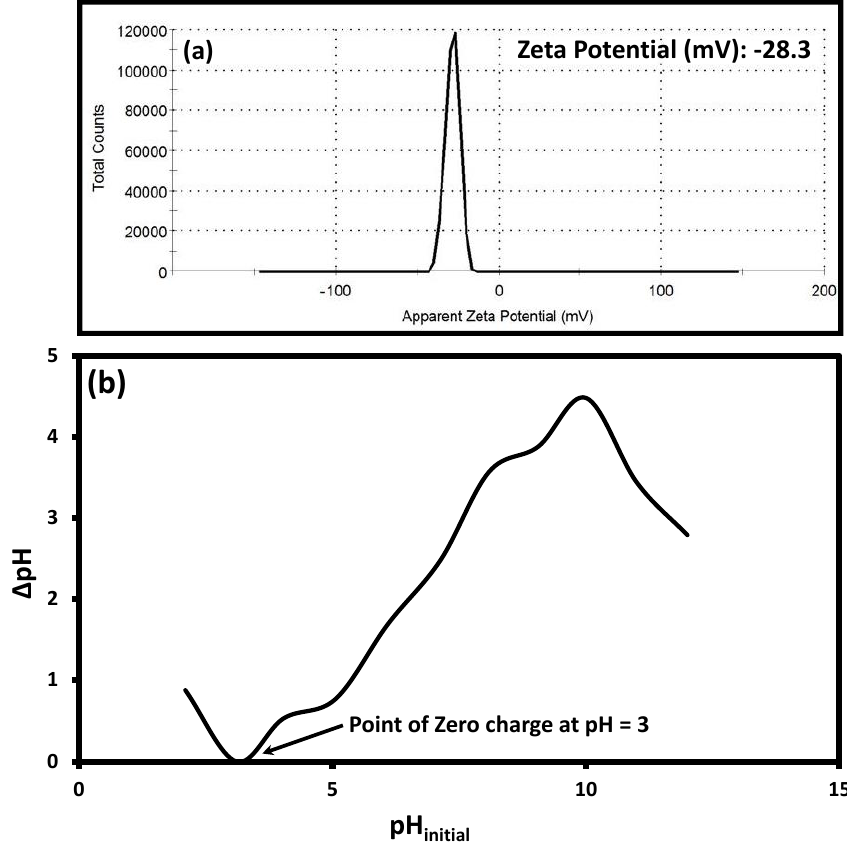
Processes 2021 , 9 , x FOR PEER REVIEW Figure 3. ( a ) Zeta potential and ( b ) Point of zero charge of PTFAC. Figure 3. ( a ) Zeta potential and ( b ) Point of zero charge of PTFAC.